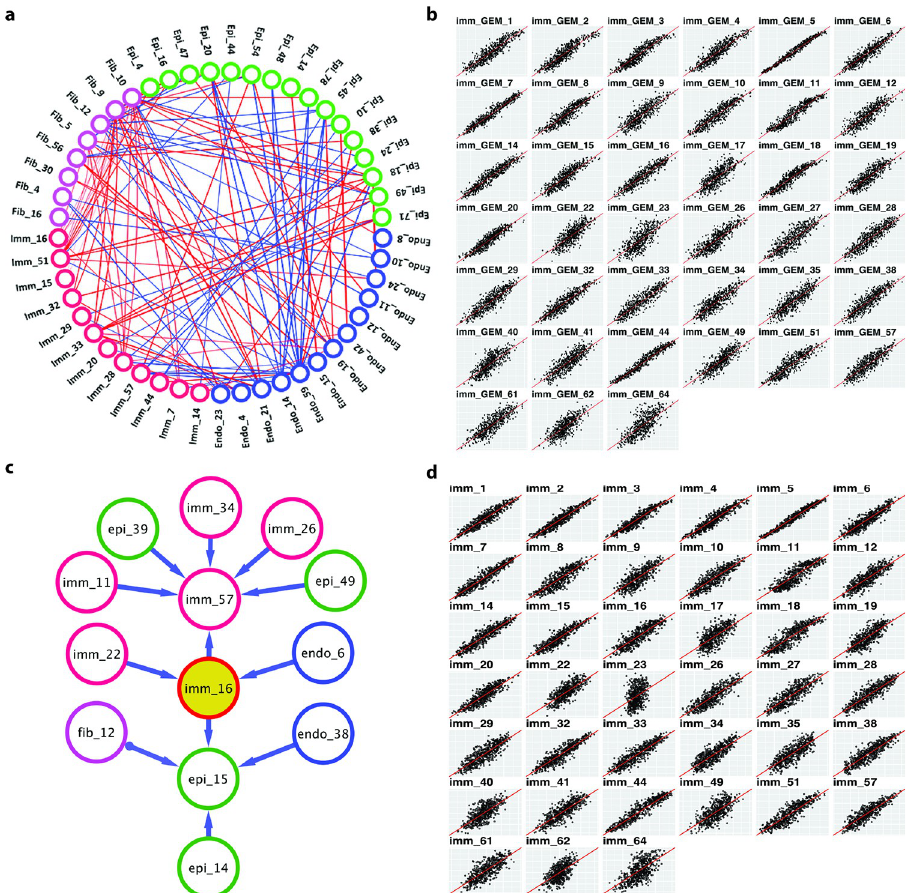
Fig 4. Intercellular communication among cells in HNSCC TMEs. a. Pair-wise correlation between GEMs from different type of cells. GEMs from major cell categories are color-coded and the top 10 strongest correlated GEMs for each cell type are shown as edges connecting the GEMs. Positive and negative correlated pairs are indicated as red and blue edges, respectively. b . Scatter plot of predicted immune GEM enrichment values using non-immune GEMs as independent variables in a regression model vs observed GEMs values. The average R 2 is 0.71. c. A subgraph of the PAG learned by GFCI algorithm. GEMs from different cell types are color-coded. A direct edge (A ➔ B) represents a direct causal relationship, i.e., A causes B. d. Scatter plot of predicted immune GEM enrichment values using the Markov boundary of a GEM as independent variables in a regression model vs observed GEM values. The mean of R 2 is 0.67, and the standard deviation is